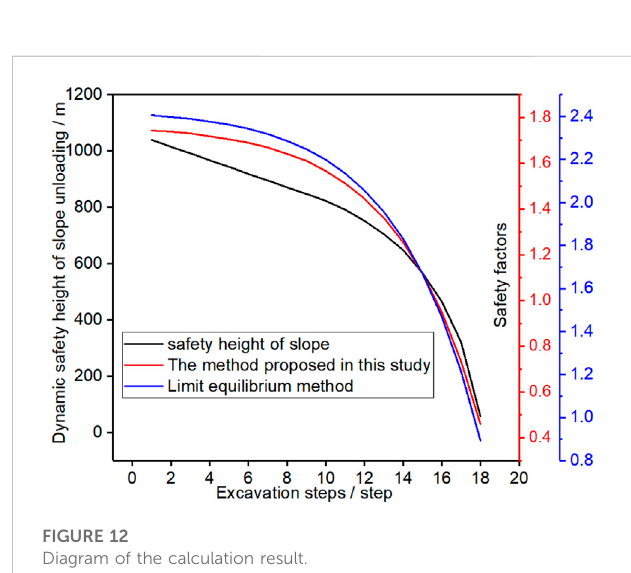
FIGURE 12 Diagram of the calculation